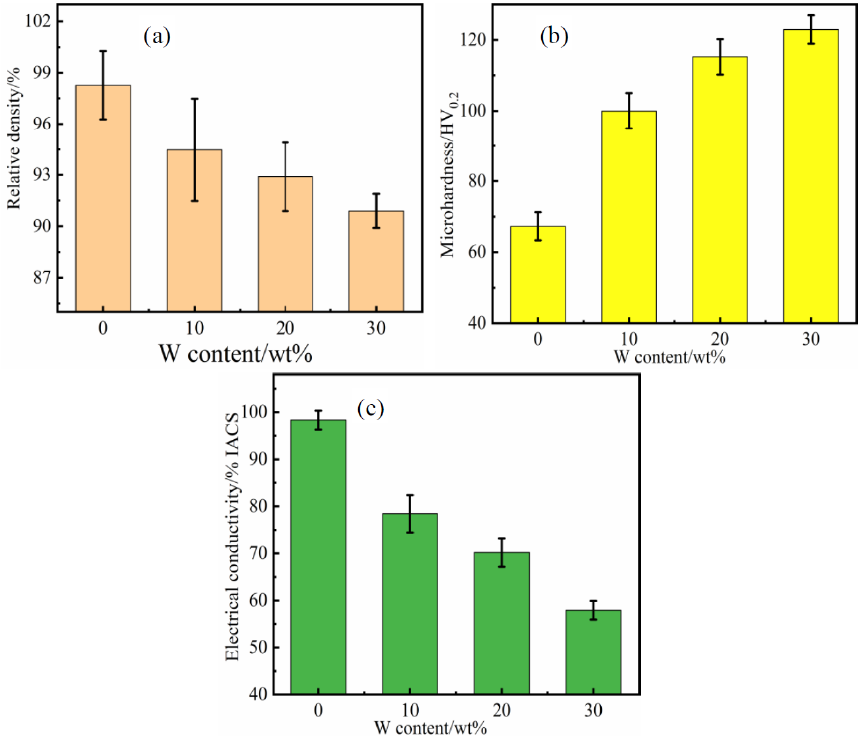
Figure 6. Properties of Cu-W composites with increasing W content: ( a ) relative density; ( b ) microhardness; ( c ) electrical conductivity.